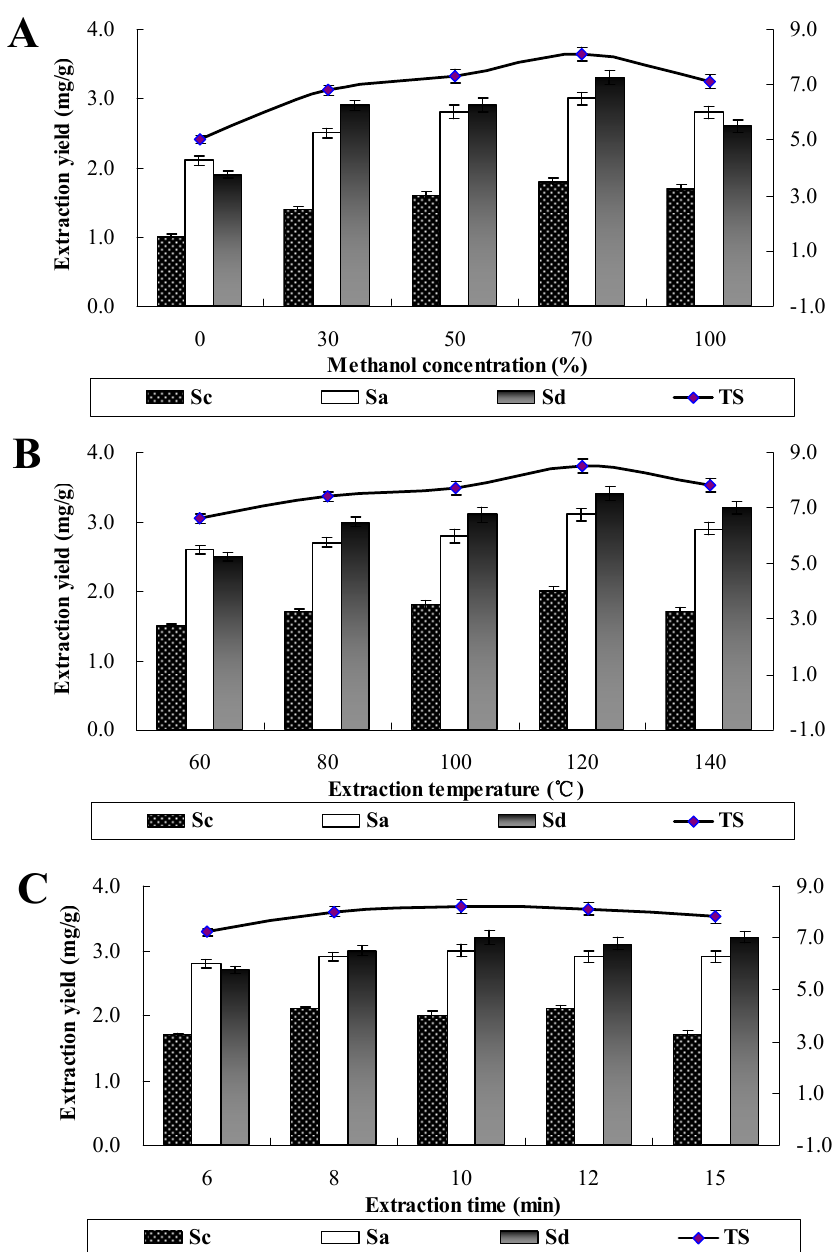
Figure 3 . Effects of extraction solvent, temperature and time on yields of three saikosaponins in B. falcatum